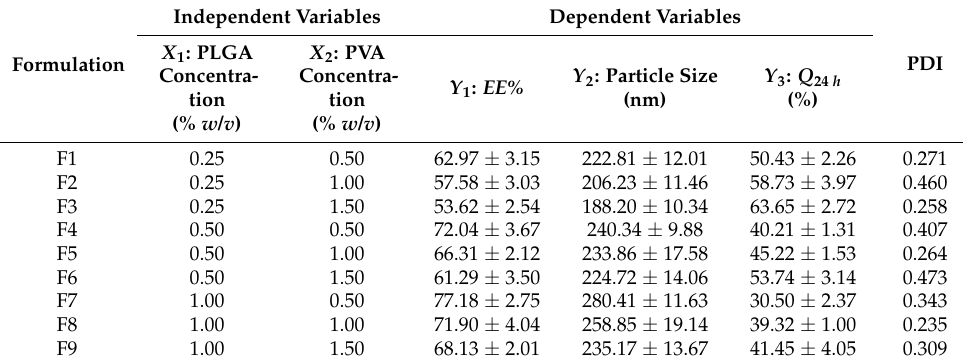
Table 2. The observed responses of NFD-CTS-PLGA nanocomposites as per the implemented 3 2 full factorial